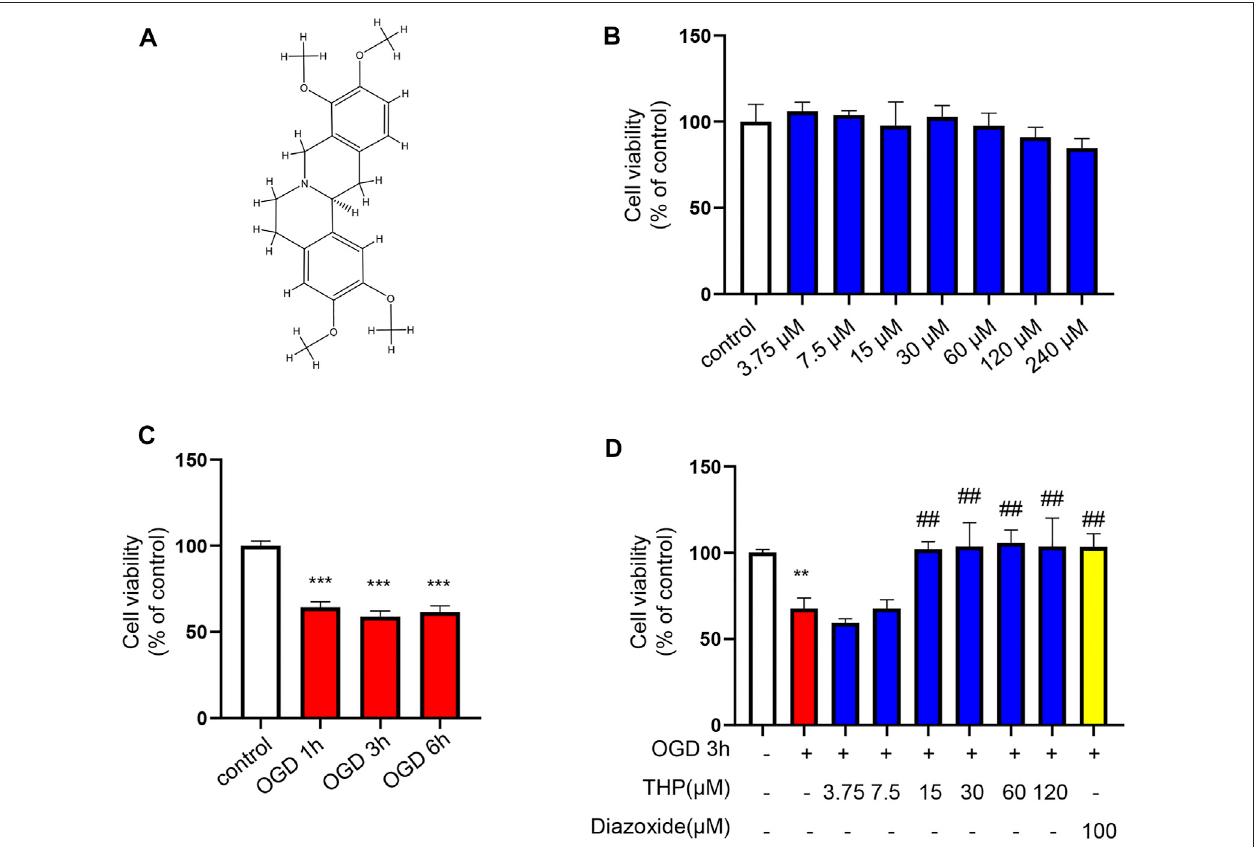
FIGURE 7 | THP had no cellular toxicity on H9c2 cells under 240 μ M and protected H9c2 against OGD-induced injury. (A) Chemical structure of THP. (B) H9c2 cells were incubated with THP for the indicated concentrations ranging from 3.75 to 240 μ M for 24 h. (C,D) The effect of THP on the OGD-induced H9c2 cells. H9c2 cells were treated with different concentrations of THP or diazoxide for 48 h following OGD exposure. Then the H9c2 cells were cultured under OGD condition for the indicated time. A CCK-8 assay was used to determine cell viability. Data are presented as the mean ± SD. ** p < 0.01, *** p < 0.001 vs. control, ## p < 0.01 vs. OGD. n = 3 (three independent